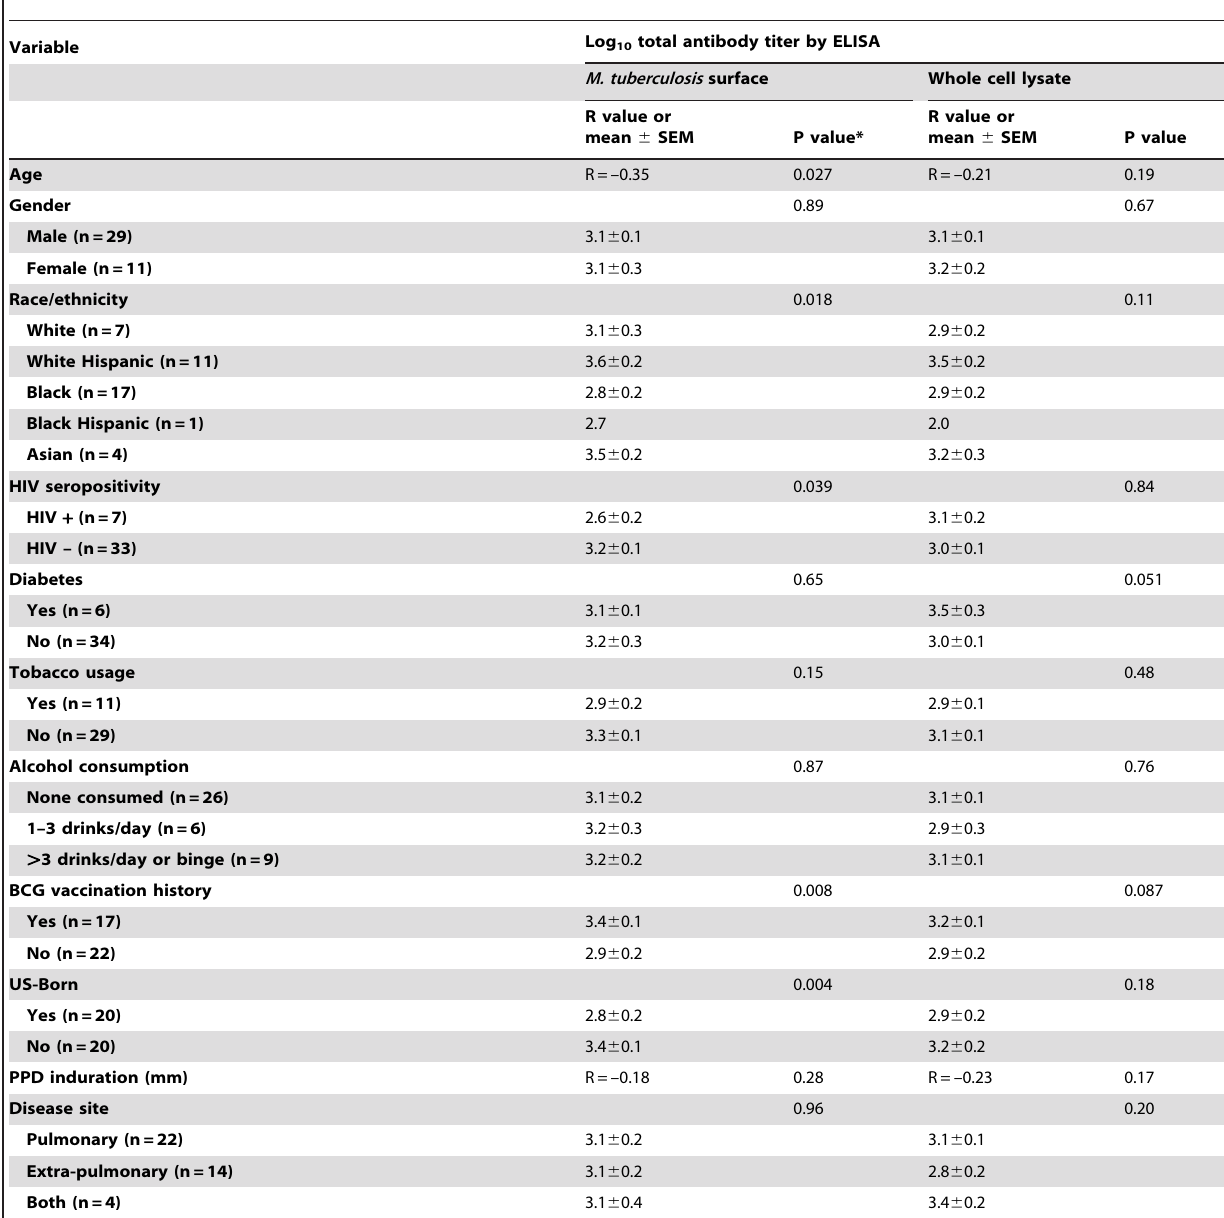
Table 2. Univariate correlation between clinical variables and total antibody titers to the live M. tuberculosis surface or to whole cell lysate in patients with active TB disease (n=